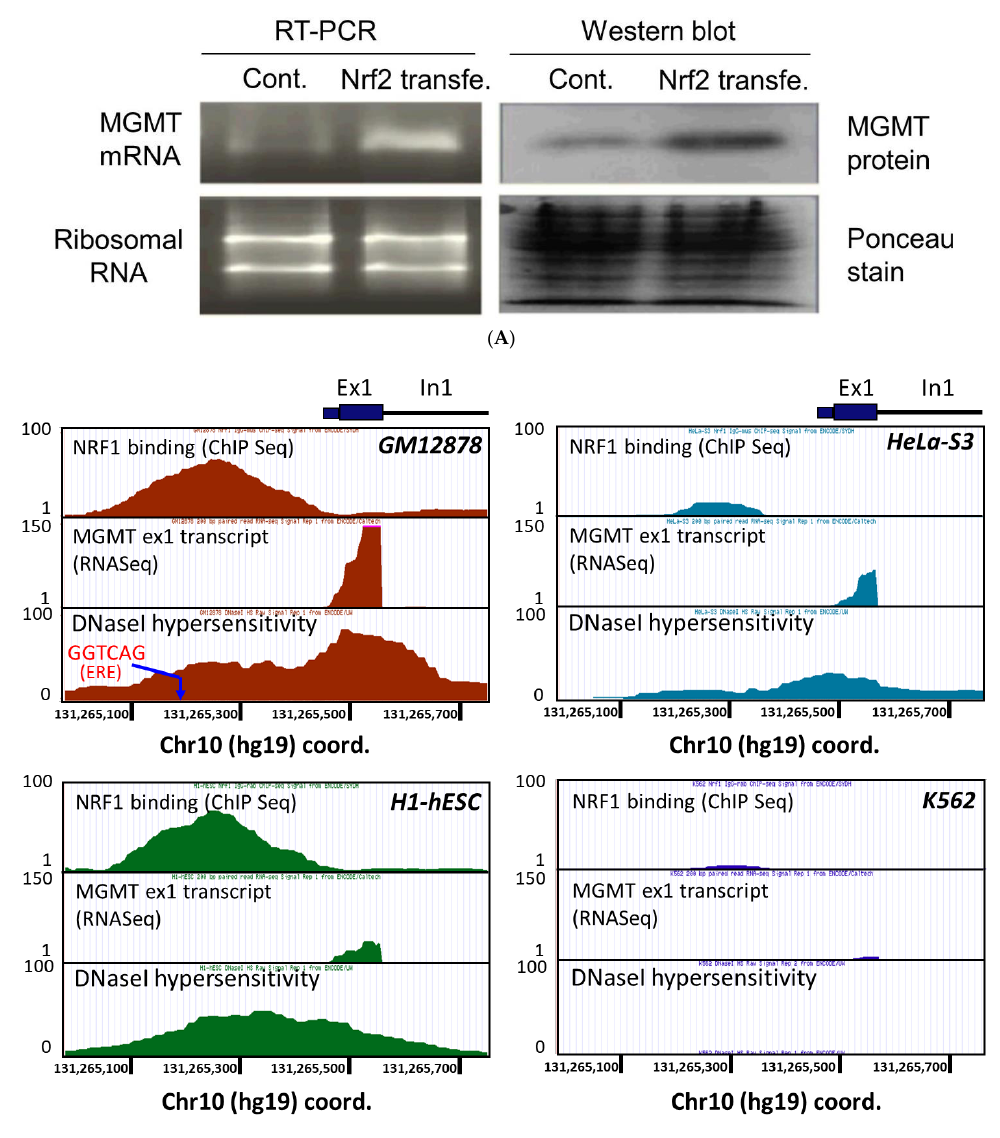
Figure 3. ( A )—Augmented MGMT transcription in NRF2 transfected SF-188 glioblastoma cells. Left panel—Total RNA isolated from the parent and transfected cells was subjected to RT-PCR using MGMT -specific primers. One µg RNA used in PCR products was electrophoresed on agarose gels at pH 8.0 and stained with ethidium bromide to show equivalent loading. Right panel–Western blot showing MGMT protein levels. The membrane stained before western blotting with Ponceau-S shows that protein loading was equal. ( B )—The relationship between the transcription factor NRF1, DNaseI hypersensitivity (a measure of chromatin accessibility), and MGMT expression as depicted in a region of MGMT locus encompassing portions of the promoter, the entire exon 1, and the 5′ end of intron 1 are represented. As shown, the MGMT- proficient cell lines GM12878, H1-hESC, and HeLa-S3 were characterized by varying intensity of NRF1 bound at the MGMT promoter region. These cell lines also exhibited DNaseI hypersensitivity at this particular region of MGMT pro- moter besides direct evidence for MGMT expression (exon 1 read counts are shown). In contrast, the cell line MGMT- deficient K562 cells were devoid of bound NRF1 at its DNaseI insensitive promoter. No MGMT transcription was evident in K562 cells. The tracks were generated from UCSC Genome Browse using three types of ENCODE sequencing data: NRF1 ChIPSeq (University of Washington), paired-end RNA Seq (California Institute of Technology), and sequencing- based Digital DNaseI hypersensitivity assay (University of Washington).